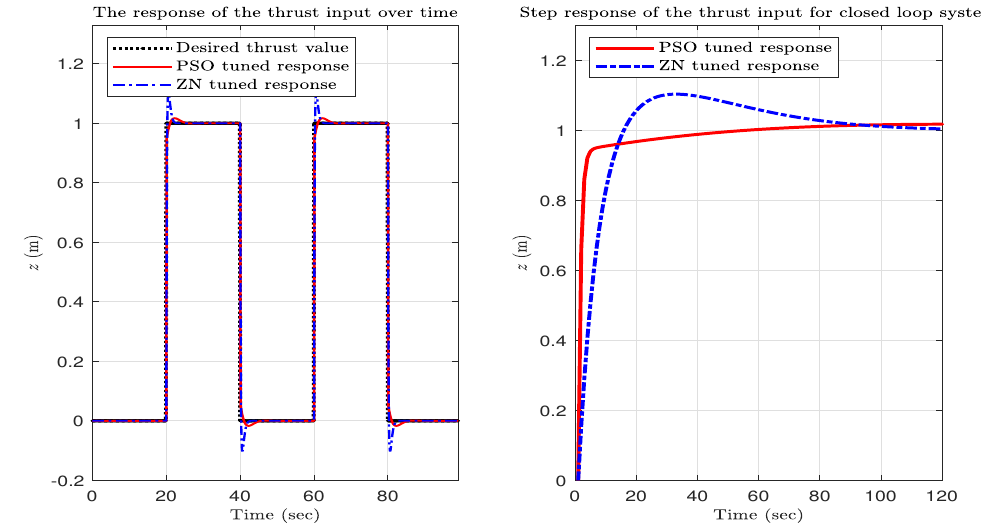
Figure 14. Simulated output responses of the thrust input of a quadcopter using PSO and ZN methods.